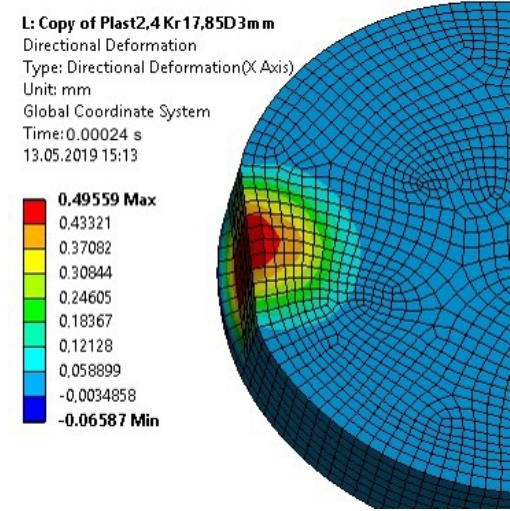
Figure 21. Plastic strain of the upper element of the specimen for a 0.00024 s calculation time after taking into account the plastic properties of the element—Model 2 (nonlinear analysis).